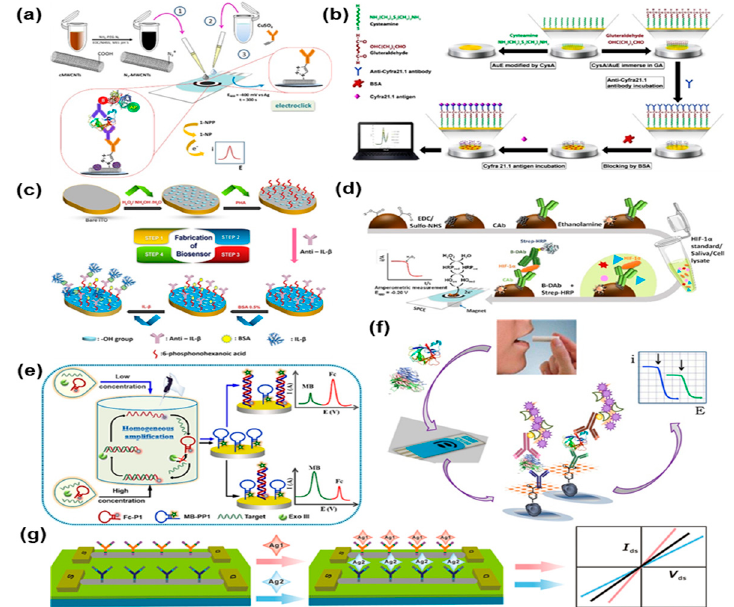
Figure 6. Summary of recently developed electrochemical biosensors for the detection of oral cancer biomarkers in saliva ( a ) Sandwich-type immunosensor for the detection of interleukin 1 β (IL-1 β ) in saliva through DPV. Reprinted with permission from ref. [111]. Copyright 2020 Elsevier. ( b ) Immunosensor for Cyfra21.1 detection based on a cysteamine and glutaraldehyde modified gold electrode. Reprinted with permission from ref. [112]. Copyright 2020 Elsevier. ( c ) Label-free immunosensor based on a modified ITO electrode for EIS detection of oral cancer biomarker in both saliva and serum. Reprinted with permission from ref. [119]. Copyright 2018 Elsevier ( d ) Magnetic beads-based sandwich immunoassay for the ampero-metric detection of HIF-1 α . Reprinted with permission from ref. [115]. Copyright 2020 Elsevier. ( e ) Ratio-metric electrochemical DNA biosensor for the detection of ORAOV1 in saliva. Reprinted with permission from ref. [102]. Copyright 2018 Elsevier. ( f ) Multiplexed immunosensor based on dual SPCEs for the simultaneous detection of IL-1 β and TNF- α . Reprinted with permission from ref. [130]. Copyright 2017 Elsevier. ( g ) SiNW sensor array for the multiplexed detection of TNF- α and IL-8. Reprinted with permission from ref. [107]. Copyright 2015 The Japan Society for Analytical Chemistry.